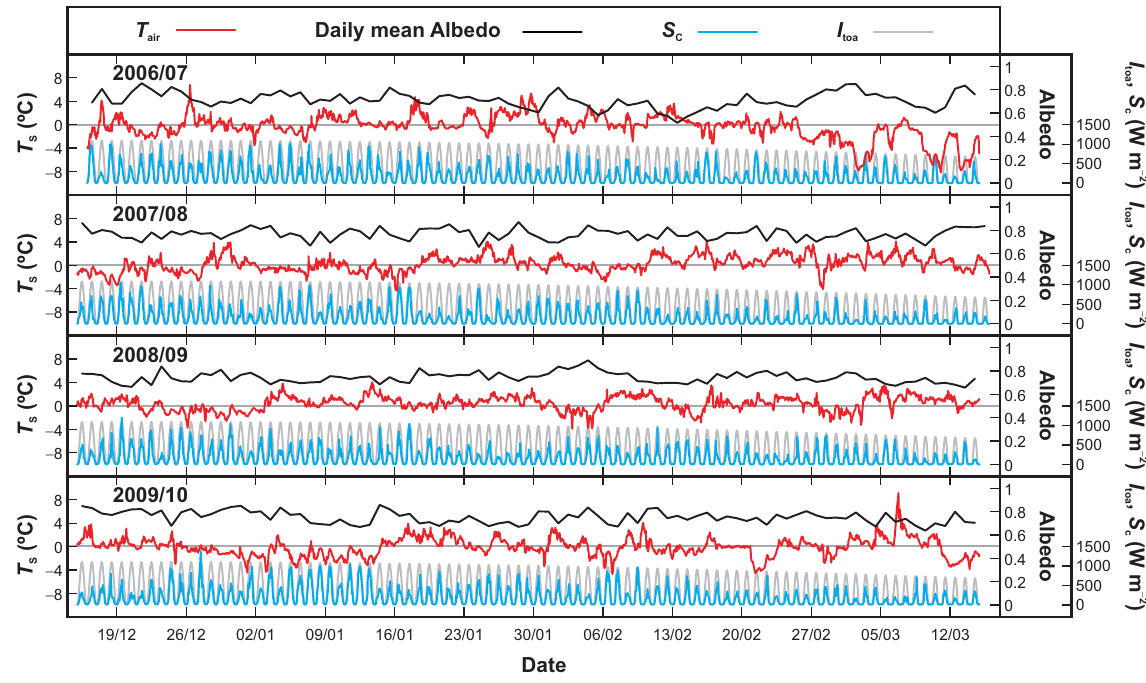
Fig. 6. Hourly T air , S c , I toa and daily mean α for the four melt seasons 2006/07–2009/10 defined as 15 December–15 March. Table 3. Mean daily T air ( ◦ C), energy fluxes (Wm − 2 ) , α c and θ i with their standard deviations, for the four melt